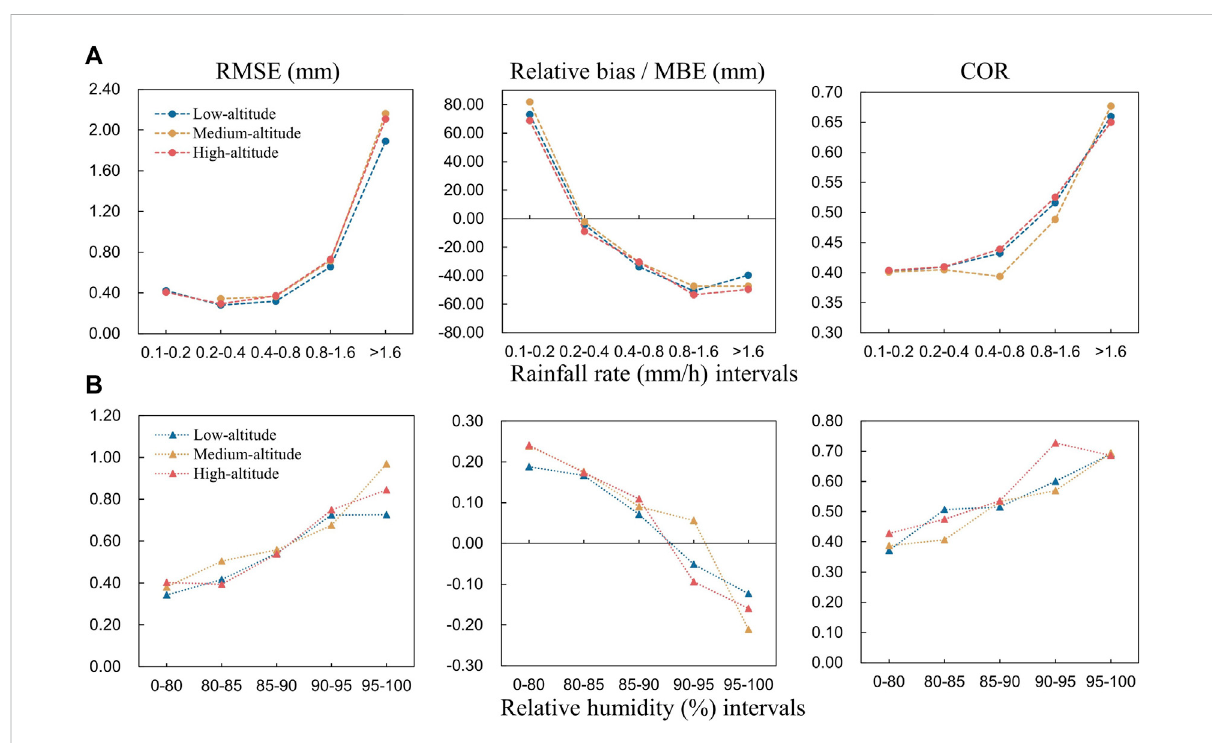
FIGURE 9 RMSE, relative bias (MBE), and COR of three classes of models at different rainfall rate and relative humidity, respectively.